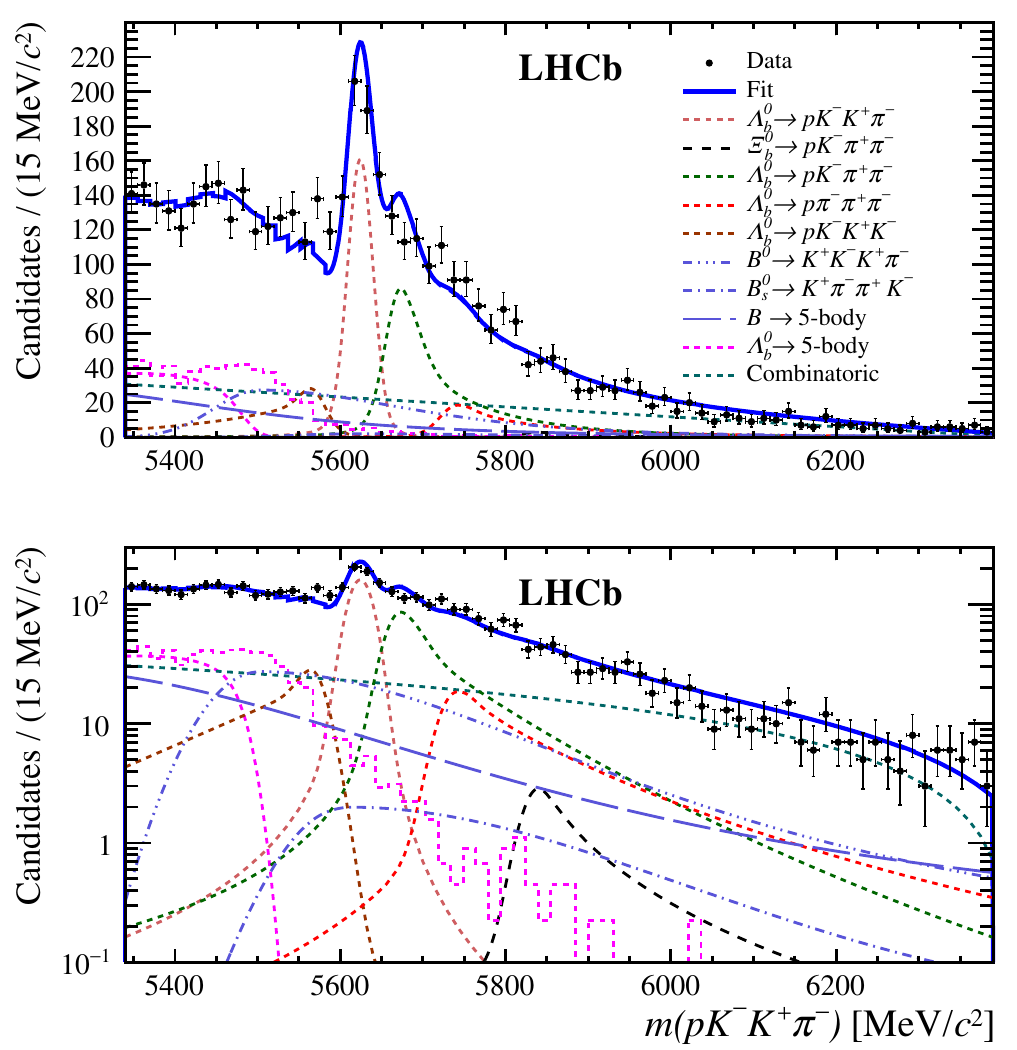
Figure 3 . Results of the (cid:12)t to the pK (cid:0) K + (cid:25) (cid:0) candidate mass spectrum with (top) linear and (bottom) logarithmic scales. The di(cid:11)erent components employed in the (cid:12)t are indicated in the legend. The (cid:3) 0 ! 5-body legend describes two components where a (cid:25) 0 is not reconstructed, the b partially reconstructed background (cid:3) 0 ! pK (cid:0) (cid:25) + (cid:25) (cid:0) (cid:25) 0 where a pion is misidenti(cid:12)ed as a kaon b